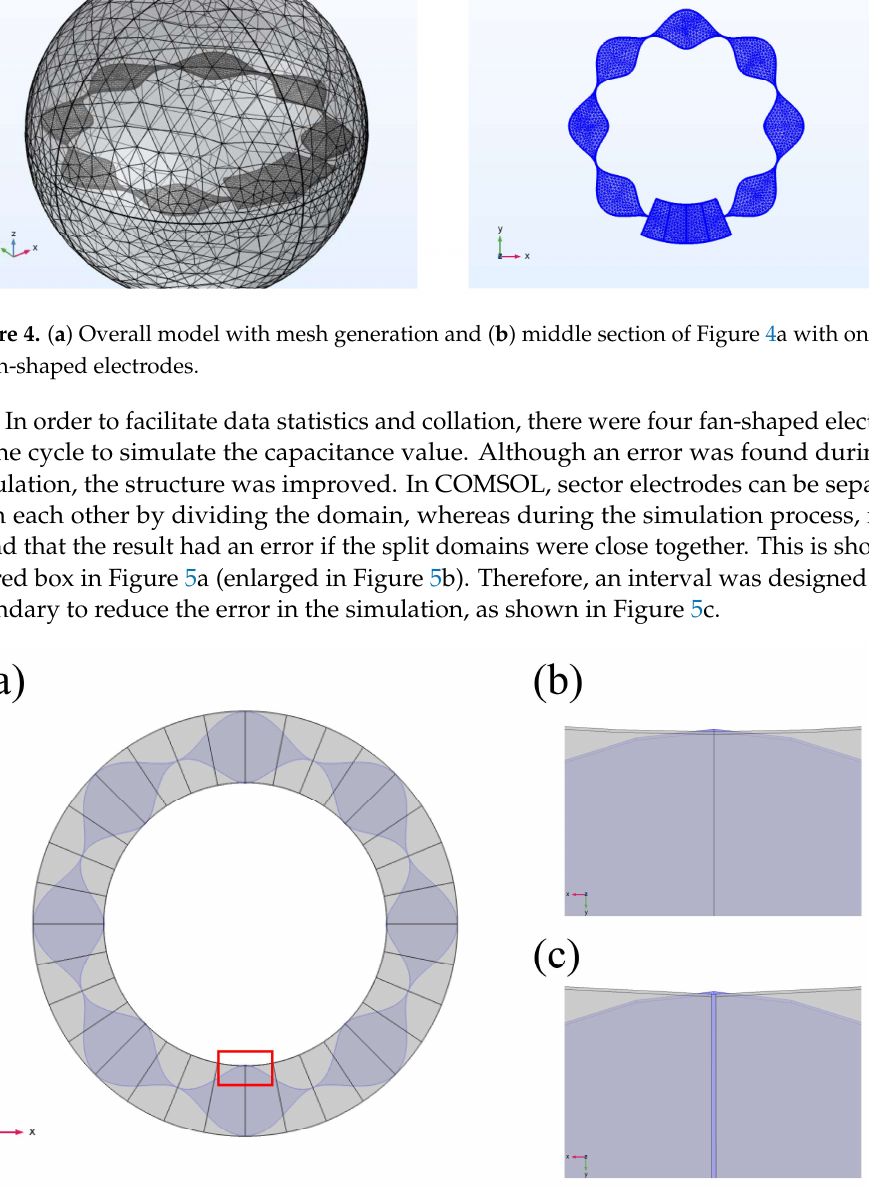
Figure 3. The parameter selection: ( a ) the relationship between the minimum capacitance and the air domain interval distance and ( b ) the relationship between the minimum capacitance and the number of cycles X; 4 and 16 cycles are examples in the illustration.